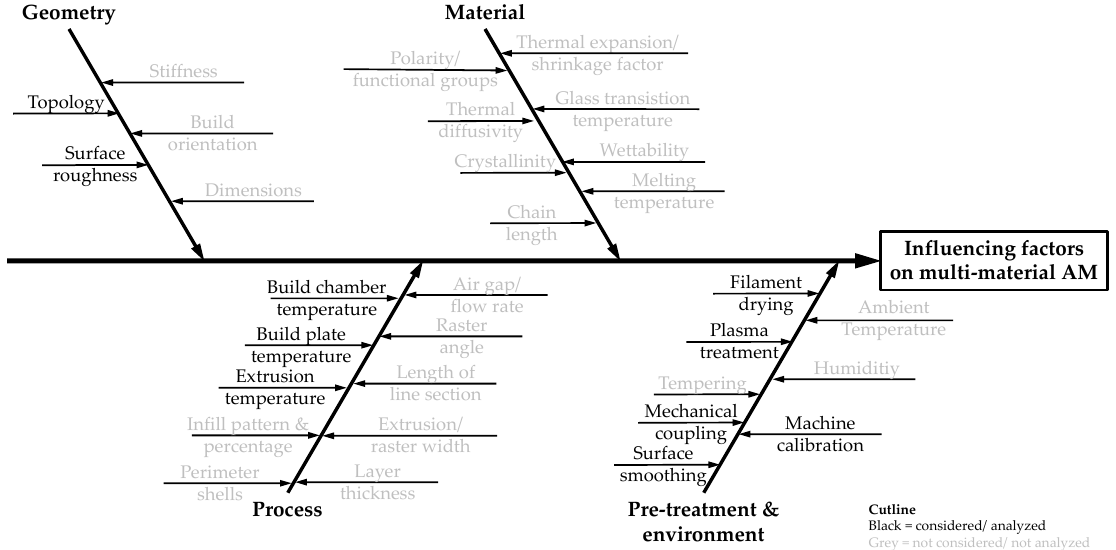
Figure 2. Fishbone diagram of possible influencing factors on interface strength of multi material AM based on References [8,21]. Enhanced by material-specific, geometrical, process-specific, and pre-treatment factors.